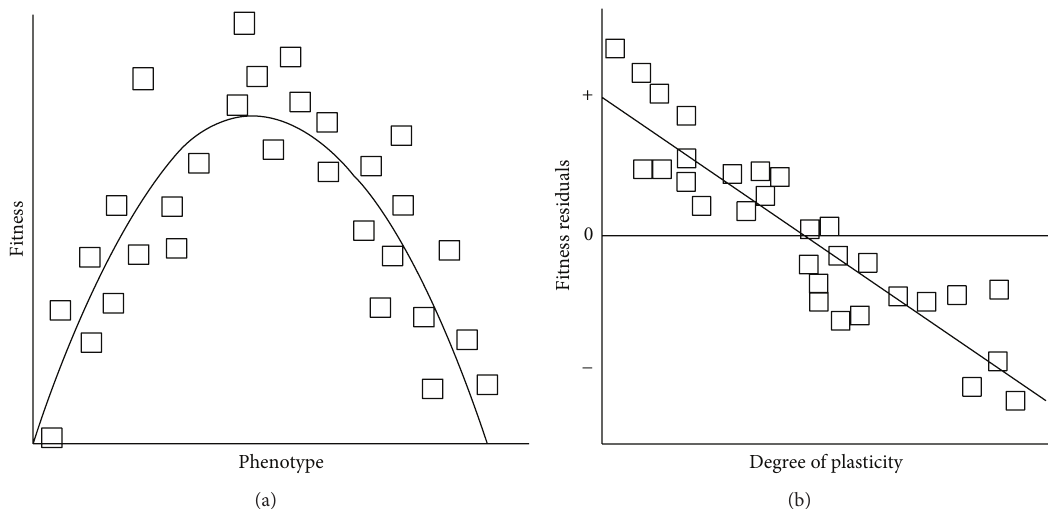
Figure 4: (a) Relationship between phenotypic values and fitness in one environment for population genotypes. (b) Relationship between degree of plasticity and fitness residuals. There is a cost of plasticity when the slope of the regression is negative from